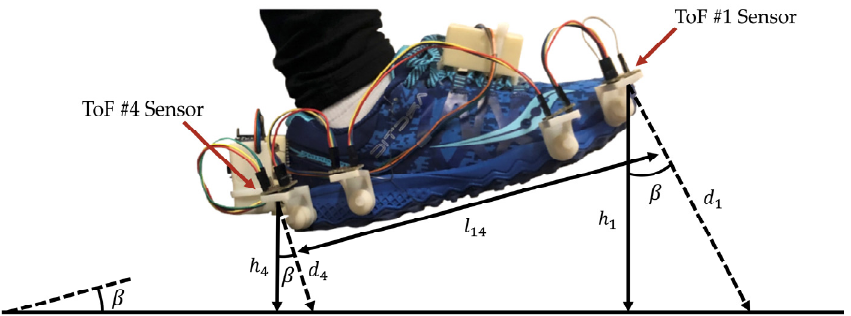
Figure 6. A labeled diagram of the foot angle, distance measurements, and sensor height to illustrate how the variables for Equations (1) and (2) were obtained to calculate the true foot-to-ground distance from each ToF sensor. This method was suggested by Arami et al. [13].